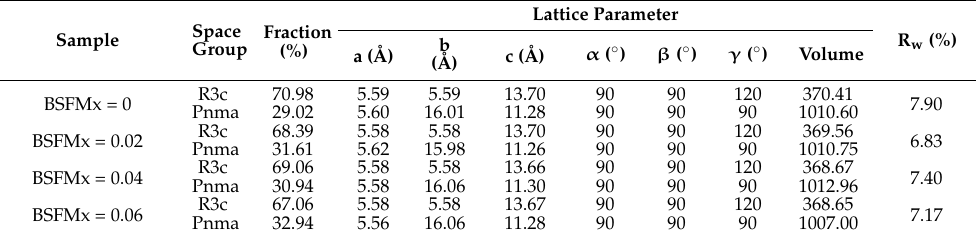
Table 1. Rietveld refinement parameters of the BSFM films with different Sm